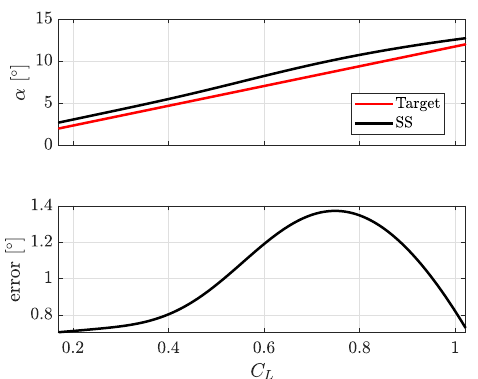
Figure 3. Estimation of α as function of the C L using the synthetic sensor designed in [24]—mean error = 1.03 ◦ , maximum error = 1.37 ◦